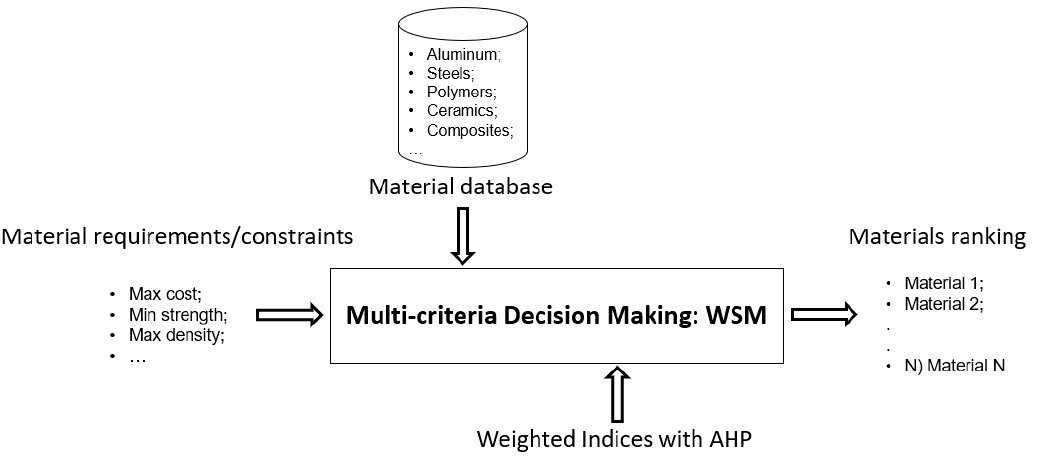
Figure 4. Materials ranking process.